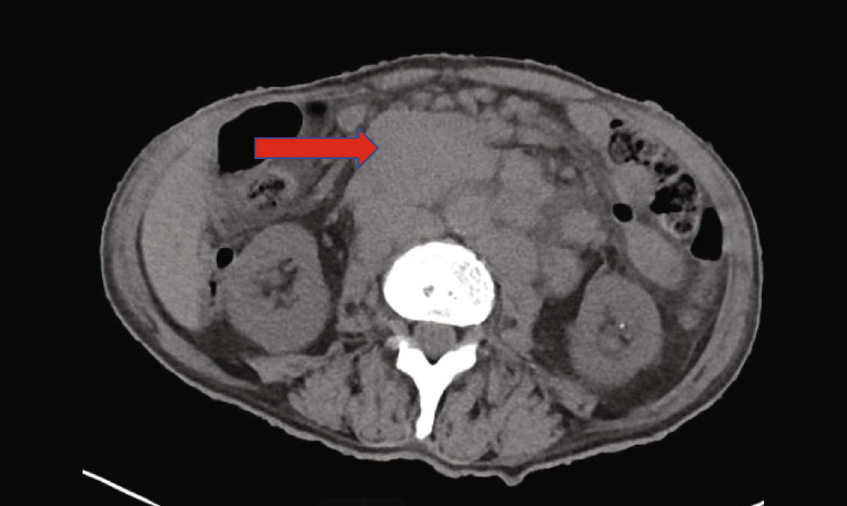
Figure 2: CT of the abdomen, axial view, showing a soft tissue mass anterior to the abdominal aorta and posterior to the body of the pancreas measuring 8 × 6 × 4 cm (red arrow) representing lymphadenopathy from the di ff use B cell